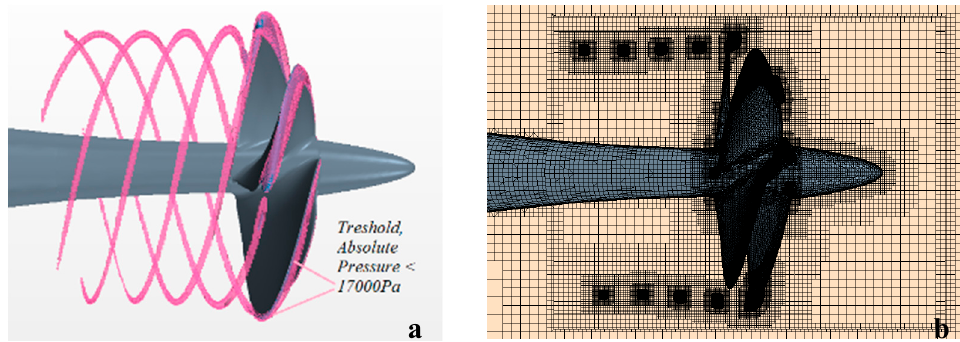
a b Figure 21. Tip vortex cavitation refinement (MARCS); ( a ) Left; Treshold Region, ( b ) Right; Generated Mesh.